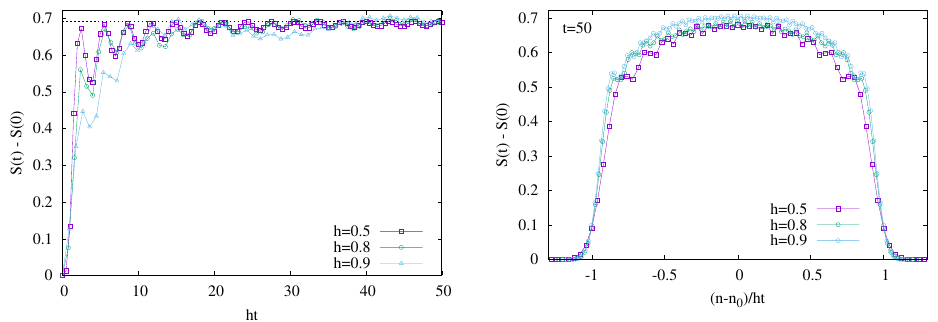
Figure 6: Time evolution of the entanglement entropy for a DW excitation in a chain of size N = 200, with the initial value S ( 0 ) subtracted. Left: half-chain entropy vs. rescaled time for various values of h . The dotted line indicates the value ln2. Right: entropy profiles vs. rescaled distance from chain centre, for fixed t = 50 and various h